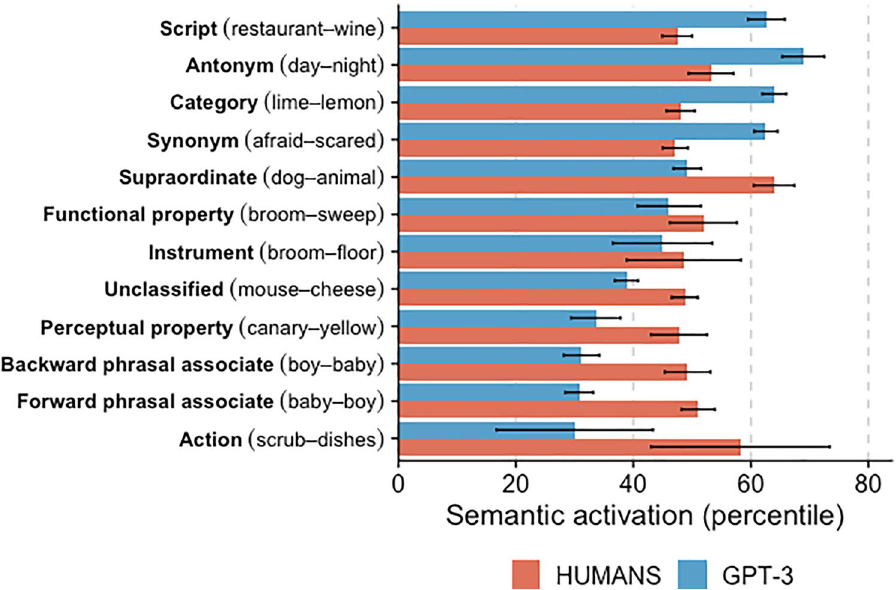
Figure 2. Semantic activation and prime-target association type. Word pairs in brackets are examples. Error bars represent 95% confidence